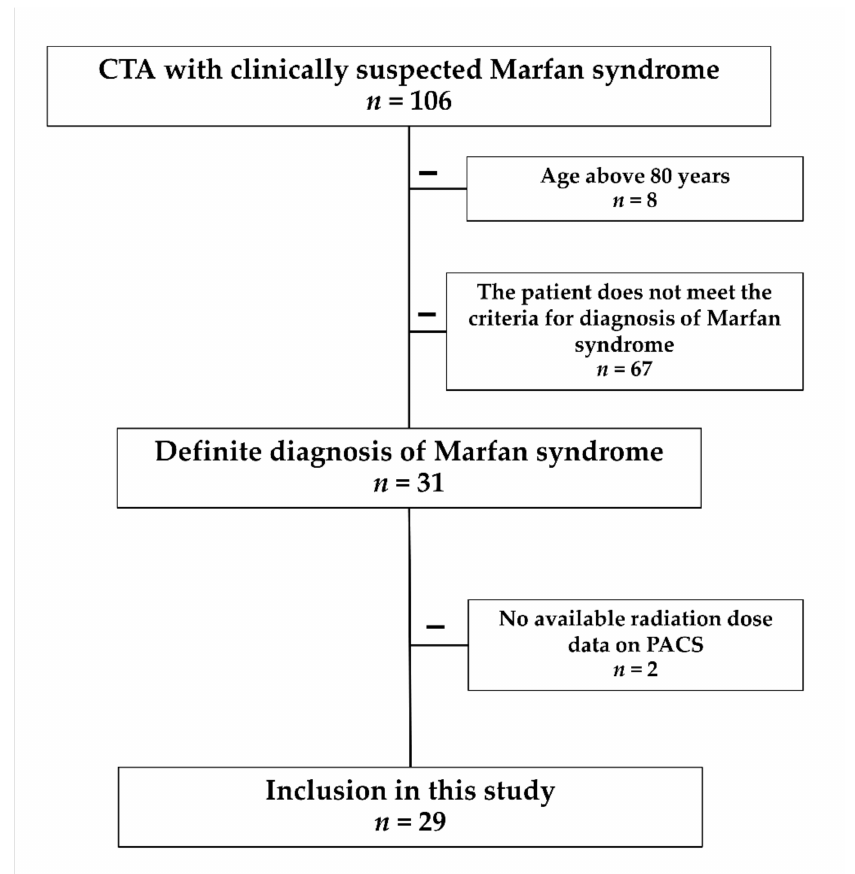
Figure 2. Flowchart for the patients’ inclusion and exclusion in the